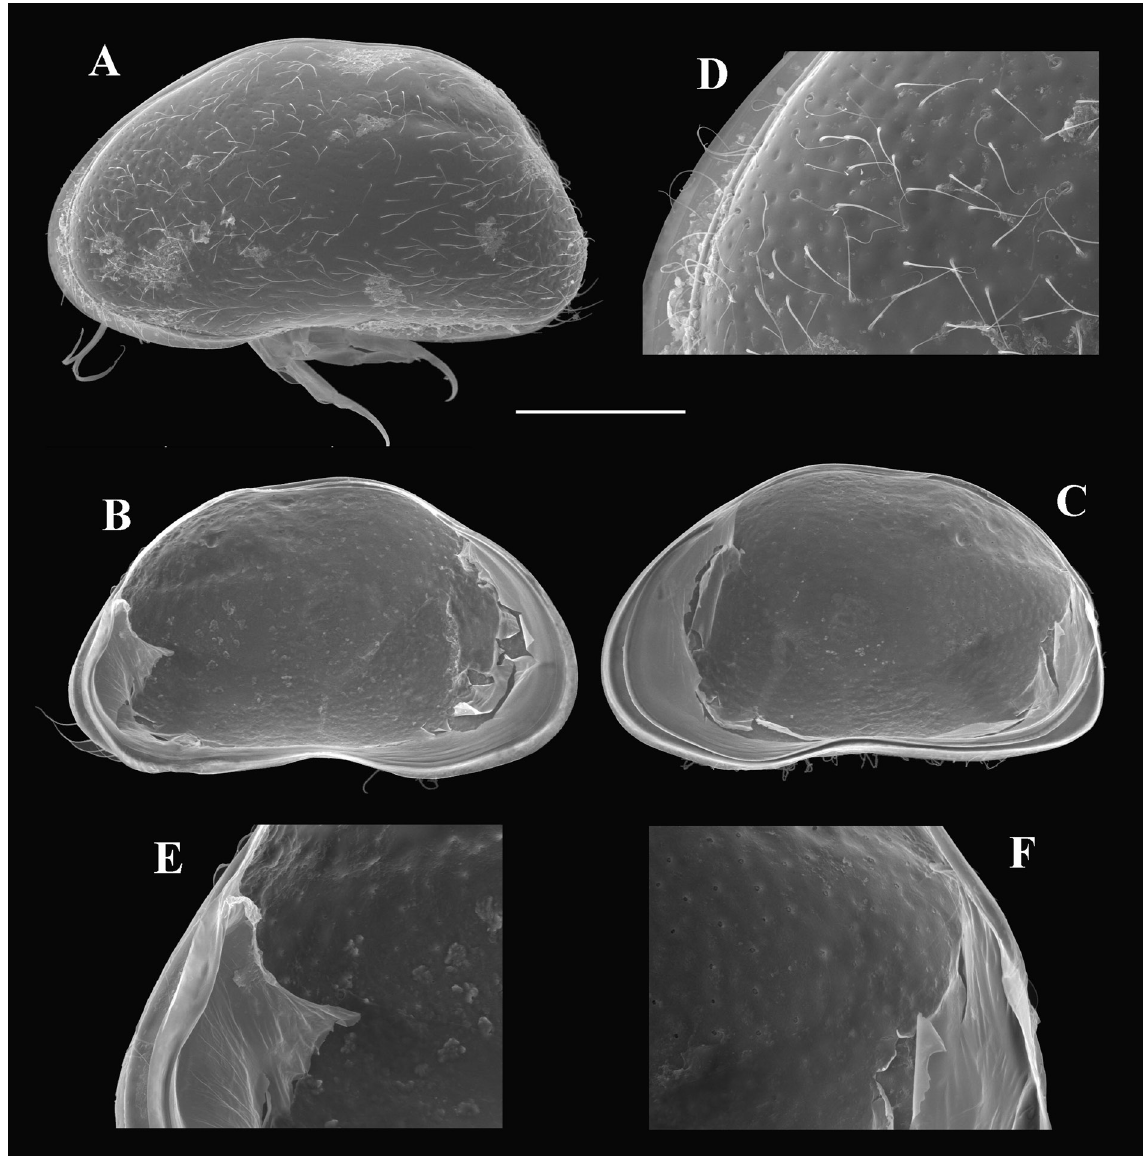
Fig. 15. Siamopsis planitia gen. et sp. nov., ♀. A . CpL (MSU-ZOC.209). B . LVi (MSU-ZOC.207). C . RVi (idem). D . Valve surface of CpL (MSU-ZOC.209). E . Postero-dorsal part of LVi (MSU-ZOC.207). F . Postero-dorsal part of RVi (idem). Scale bar: A–C = 200 μm; D = 64 μm; E–F = 85